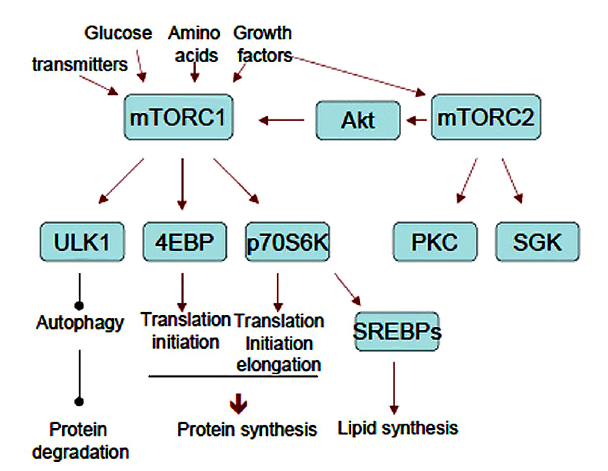
FIGURE 2 |The flow sheet of upstream and downstream of mTORCs. Representative substrates and cellular responses mentioned in the text are shown. Note that mTORC2 activates mTORC1 through